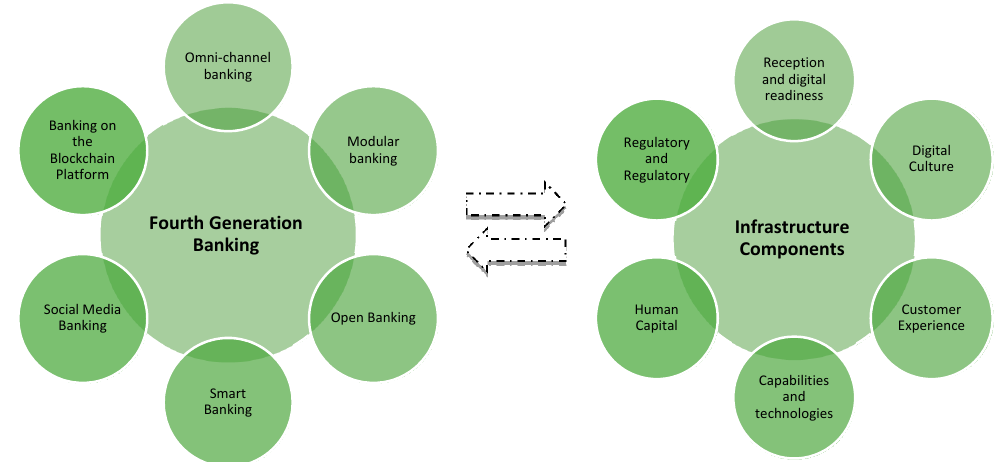
Figure 5. The relationship between Banking 4.0 and infrastructure. Source: Own contribution of the